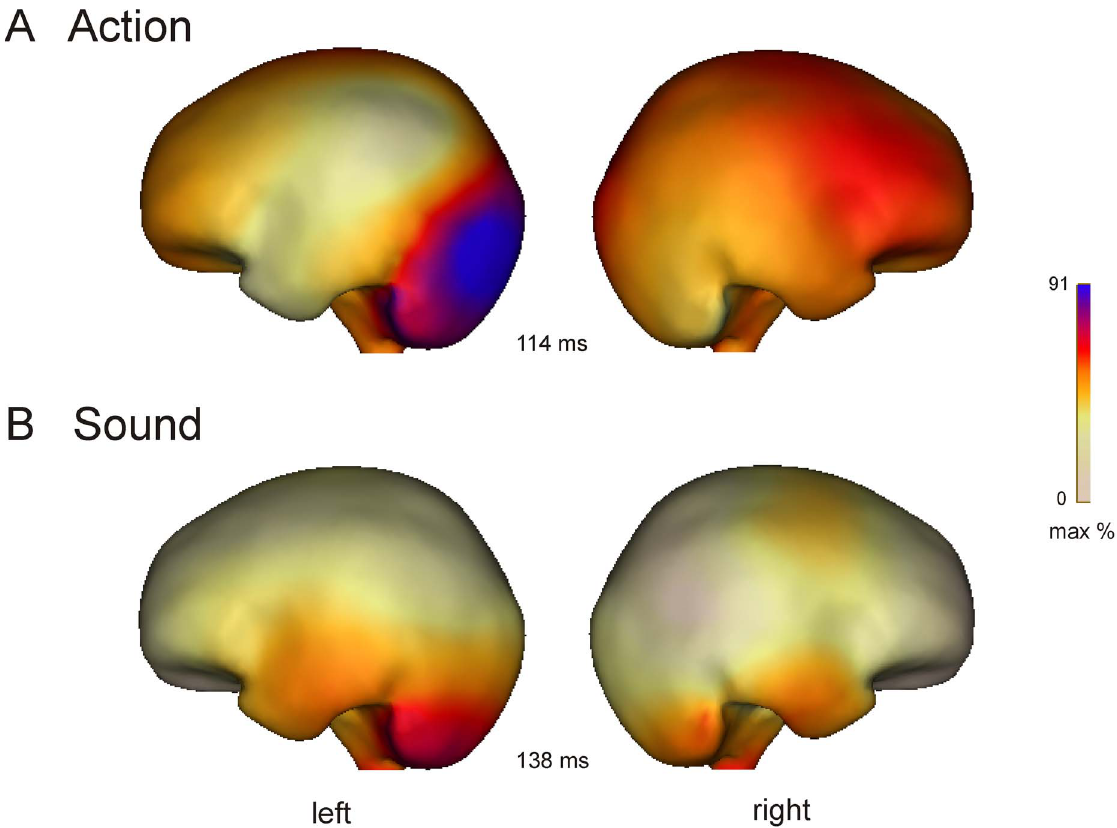
Figure 4. Neural source estimates of scalp potentials calculated according to the minimum norm algorithm from ERP difference waves as a function of feature type. (A) Source of the significant action feature-priming effect (B) Source of the significant sound feature-priming effect.